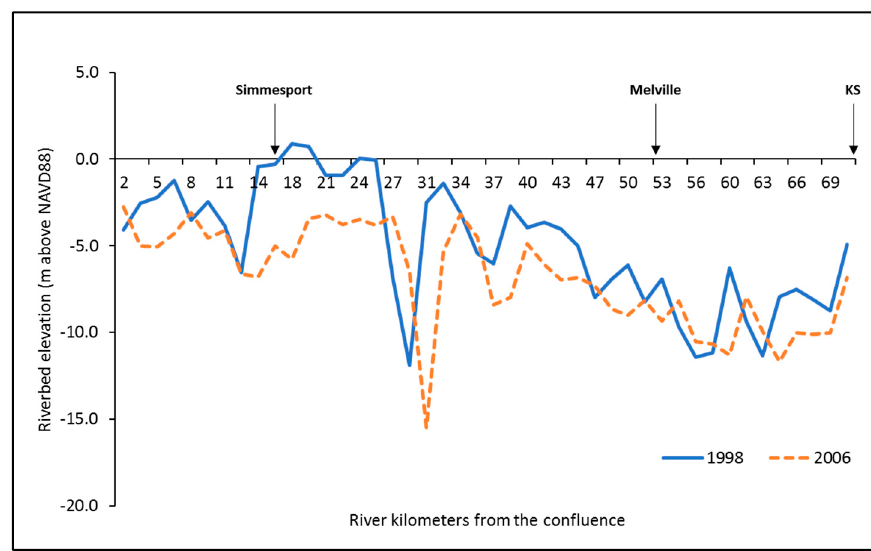
Figure 5. Changes in average bed elevation during 1998–2006 in the uppermost Atchafalaya River. The channel is a 69-km reach downstream of the Outflow Channel (OC) outlet of the Mississippi-Atchafalaya River diversion (RK 0). The x -axis is the river kilometers from the confluence on the Red River and the Outflow Channel.